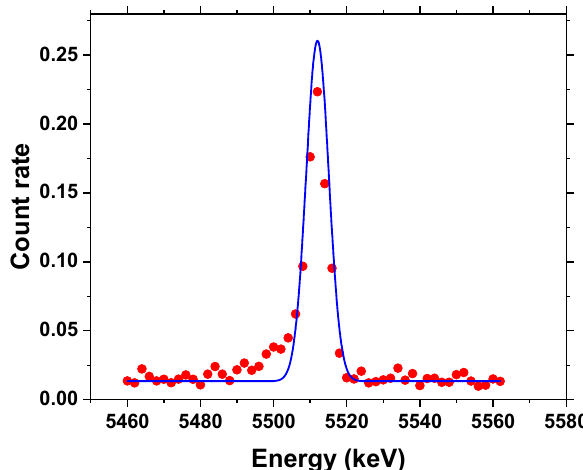
Figure 7. Gaussian fitted NRF peak of 208 Pb at 5512 keV.